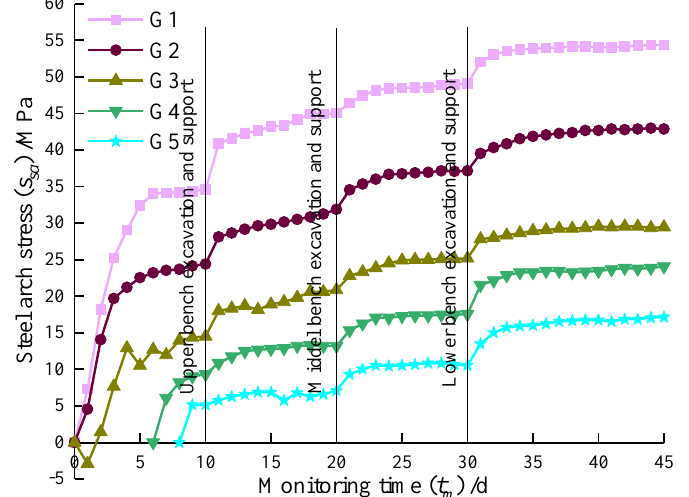
Figure 13. Time history curves of the stress of the steel arch at YK58 + 570 (in 2020).